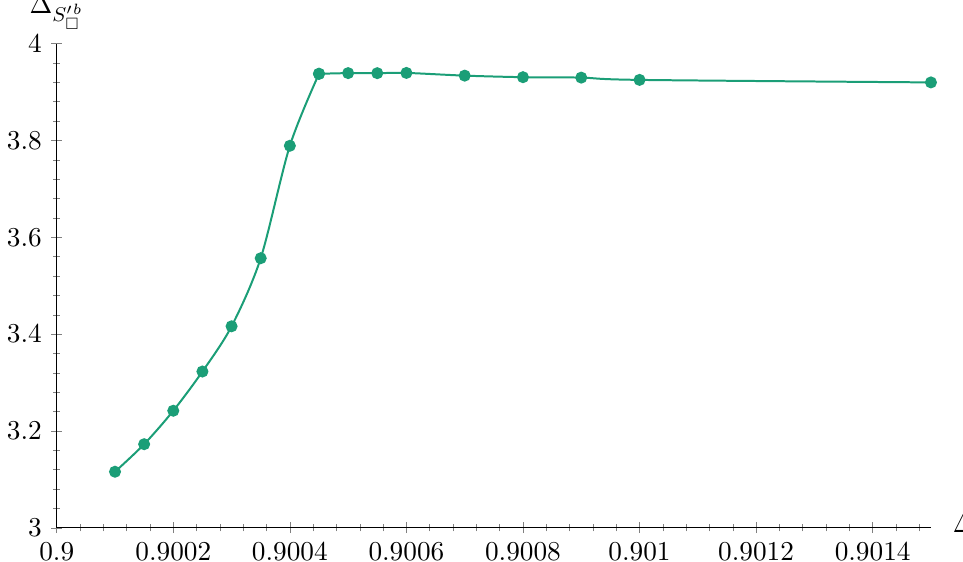
Figure 18 . The dimension of S 0 b the bound of (cid:12)gure 16. The markers indicate the points at which we have computed the